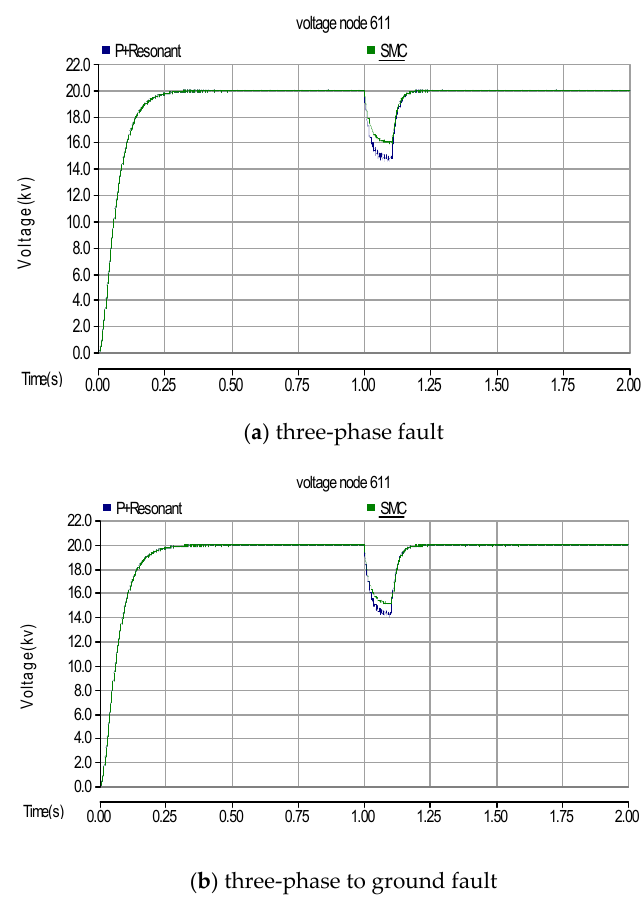
Figure 7. Voltage domain variations in bus 611 due to unsymmetrical short circuit faults in bus 671 and compensation with P+Resonant and SMC control systems.